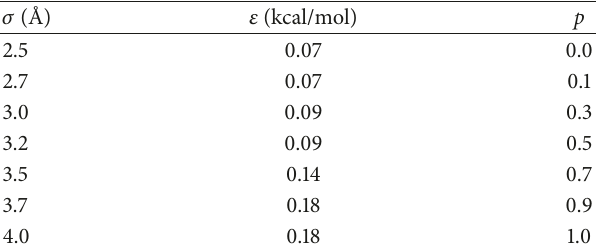
Table 1: Parameters employed in the molecular dynamics simula-